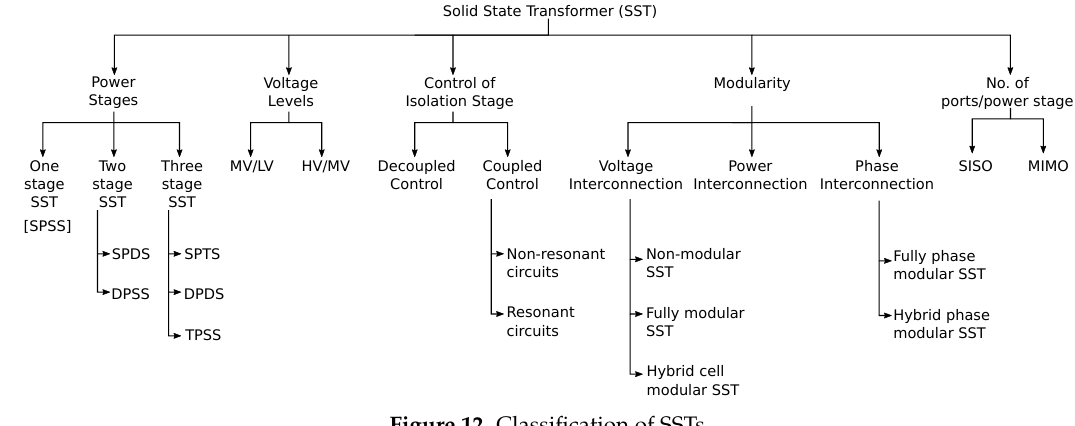
Figure 12. Classification of